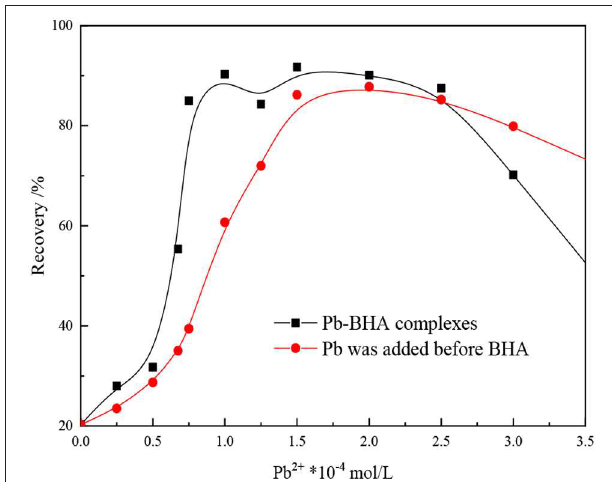
FIGURE 1 | Effect of mode of addition on flotation of scheelite (pH = 8.8 ± 0.2, C BHA = 1.5 × 10 − 4 mol/L, C terpineol = 12.5 µ